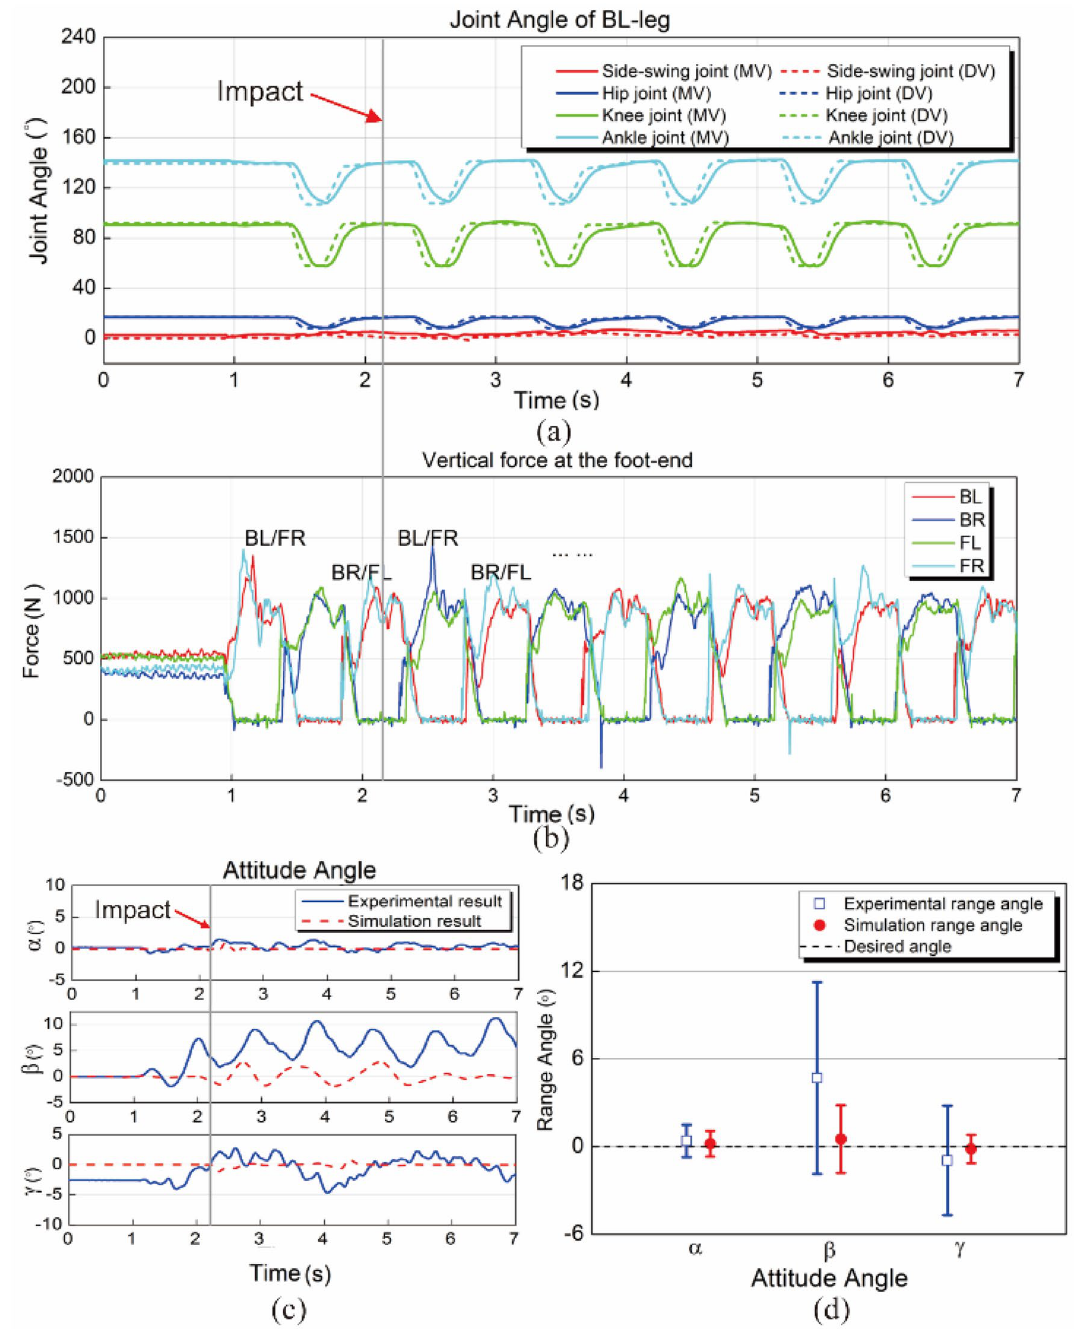
Figure 21. Experimental results. ( a ) Joint angle curves of the front-left leg. ( b ) Vertical force at the foot-end. ( c ) Attitude angles under the lateral impact. ( d ) Range of the attitude